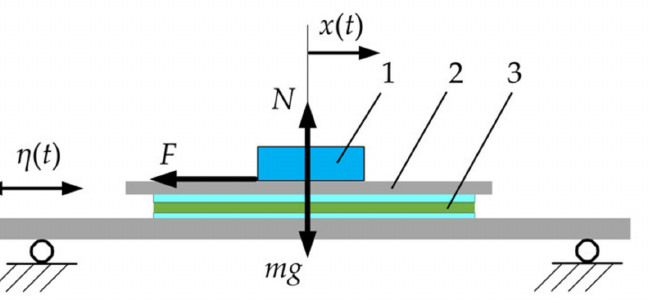
Figure 1. Scheme of nonprehensile manipulation on a harmonically oscillating platform with dry friction control: (1), body to be manipulated; (2), platform; (3), actuators for dry friction